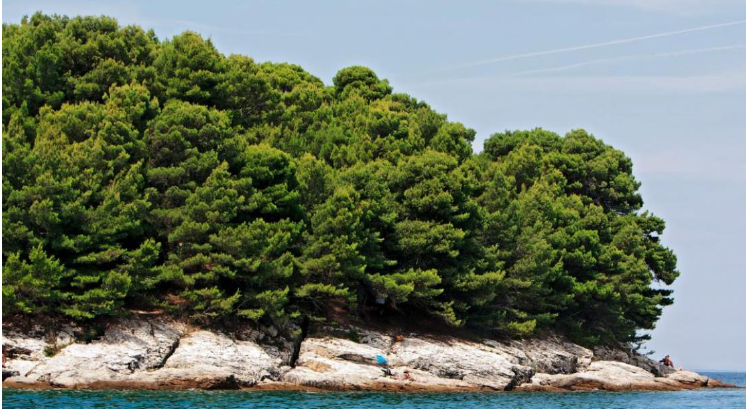
Figure 24. Aleppo pine along coast of Ošljak .